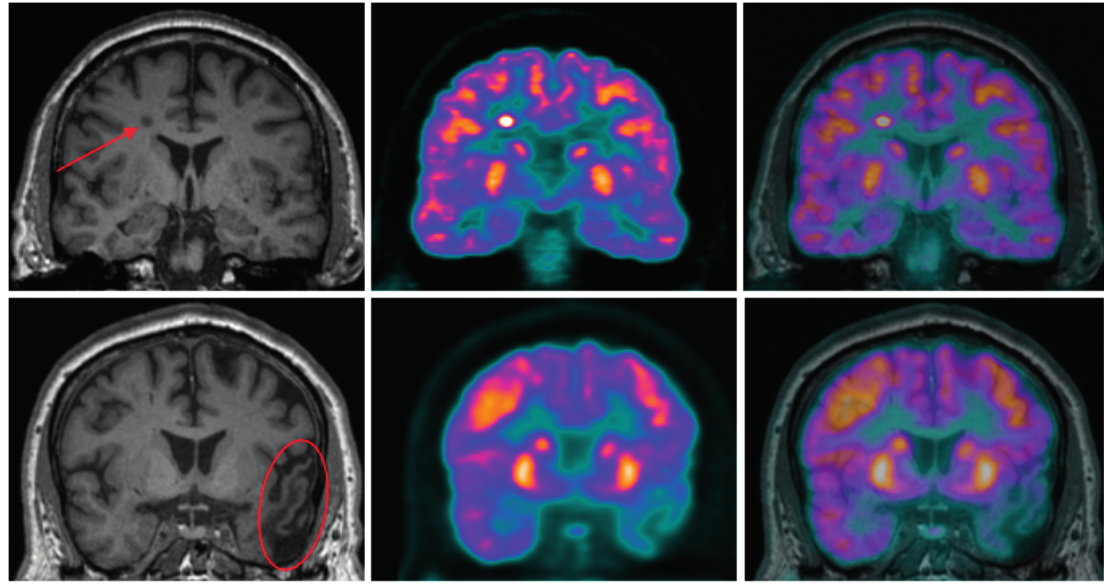
Figure 3. Coronal high-resolution T1-weighted MR (left) and PET (center) images of two pulmonary carcinoma patients scanned at LHRI, London, Ontario, Canada using a Siemens Biograph mMR PET-MR hybrid scanner. The PET- 18 F-FDG and MR images were acquired simultaneously and, the PET was later superimposed onto the MR images